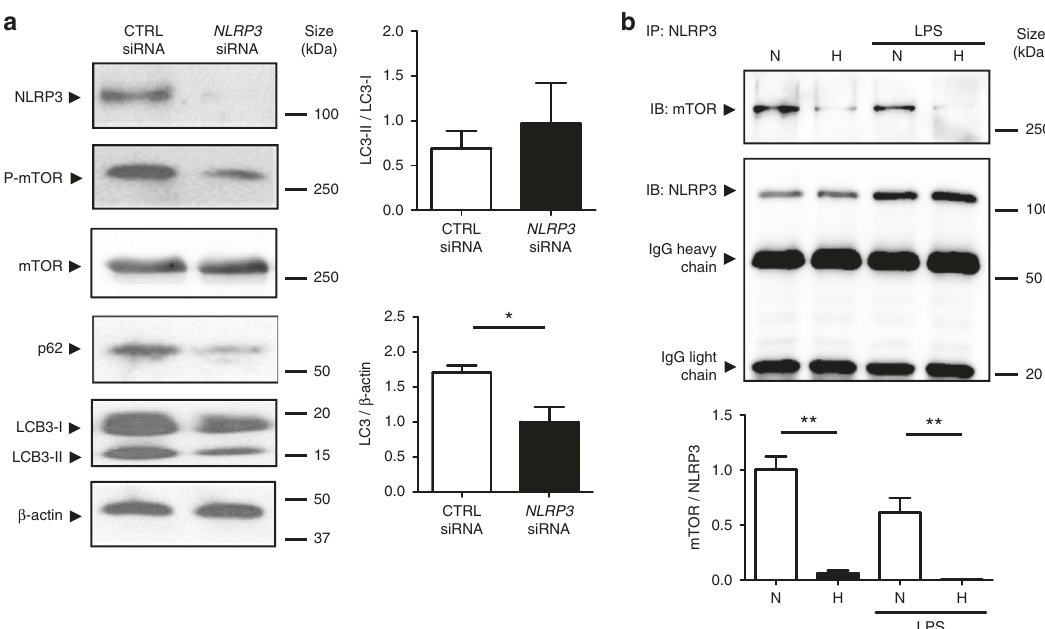
Fig. 6 NLRP3 regulates autophagy through an in fl ammasome-independent mechanism via direct binding to mTOR. a HT-29 cells were transfected with NLRP3-speci fi c siRNA or negative control siRNA using Lipofectamine RNAiMAX. Forty-eight hours after transfection, total protein was isolated and western blot performed. Quanti fi cation of the ratio of LC3-II/LC3-I and the total amount of LC3 (LC3-I plus LC3-II) relative to β -actin is presented. Statistical analysis was performed using Student t -test. Results represent mean + s.e.m. of three independent experiments, * P < 0.05. b HT-29 cells were subjected to normoxia (21% O 2 ) or hypoxia (0.2% O 2 ) for 24 h in the presence and absence of LPS. Co-IP using NLRP3 antibody was performed, followed by anti-mTOR immunoblotting. Quanti fi cation relative to cells subjected to normoxia in the absence of LPS after normalization to NLRP3 is presented. Statistical analysis was performed using one-way ANOVA followed by Tukey ’ s post-test. Results represent mean of three independent experiments + s.e.m., ** P <